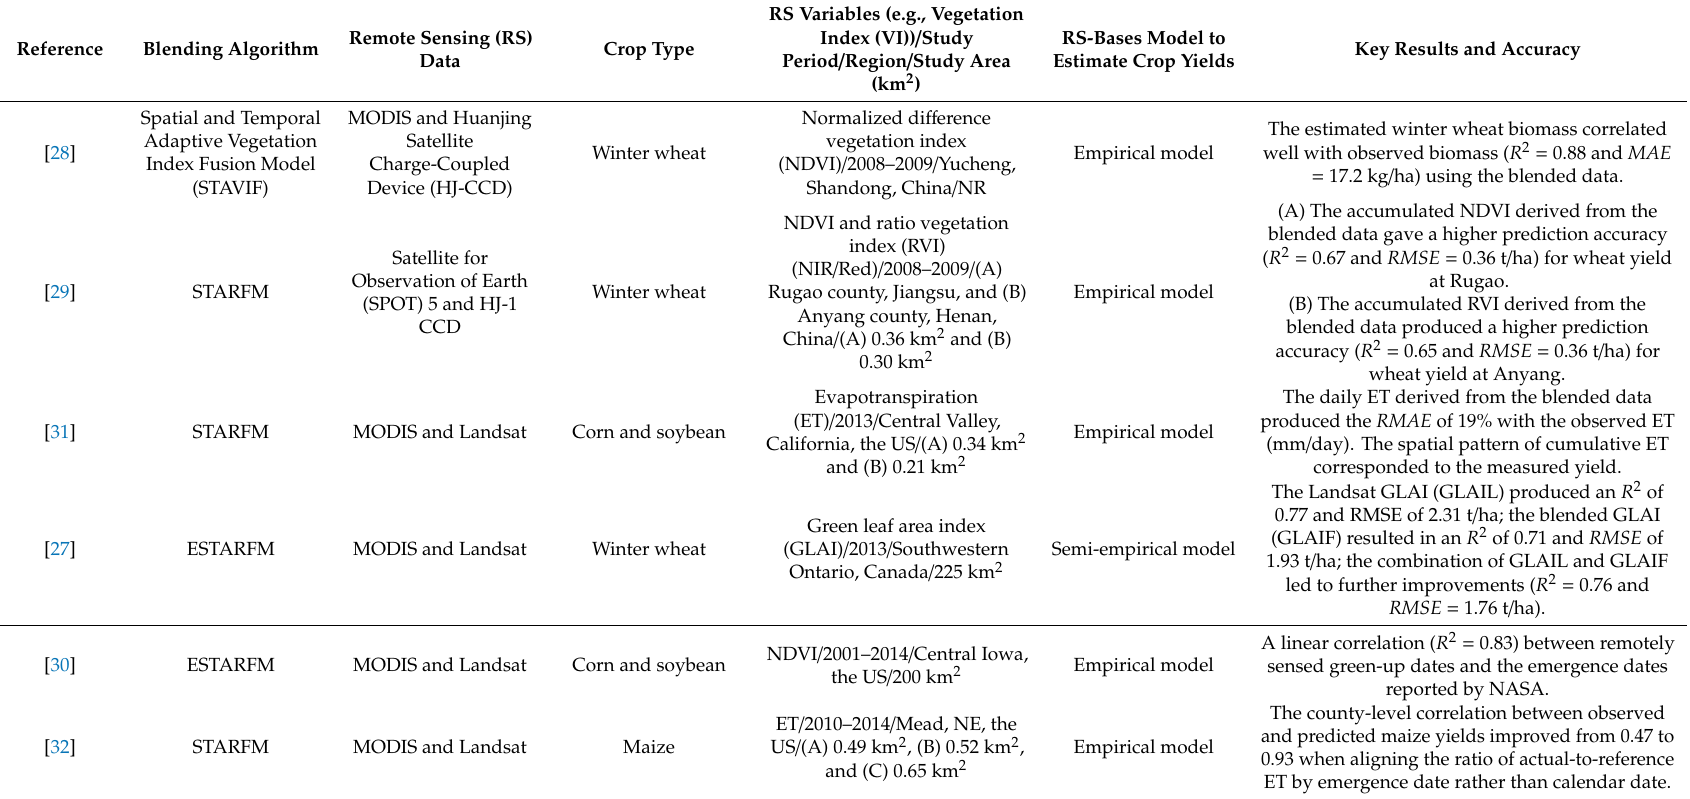
Table 1. Review of studies that used data fusion approaches to estimate crop yields and other variables highly related to crop yield (e.g., growing season evapotranspiration and crop phenology). Records are sorted chronologically then alphabetically. When more than one site is reported in a single paper, these are identified with an (A) and (B) in the relevant columns as required. R 2 : the coe ffi cient of determination; RMSE : root-mean-square error; MAE : mean absolute error; RMAE : relative MAE ; NR : not reported. In Australia, dryland agriculture is practiced across the region known colloquially as the “wheatbelt”. STARFM—Spatial and Temporal Adaptive Reflectance Fusion Model; ESTARFM—enhanced STARFM; MODIS—Moderate Resolution Imaging Spectroradiometer; NIR—near infrared; US—United States; NE—New England; NASA—National Aeronautics and Space Administration; L–M—Landsat / MODIS blend; HTF—high temporal frequency; HSR—high spatial